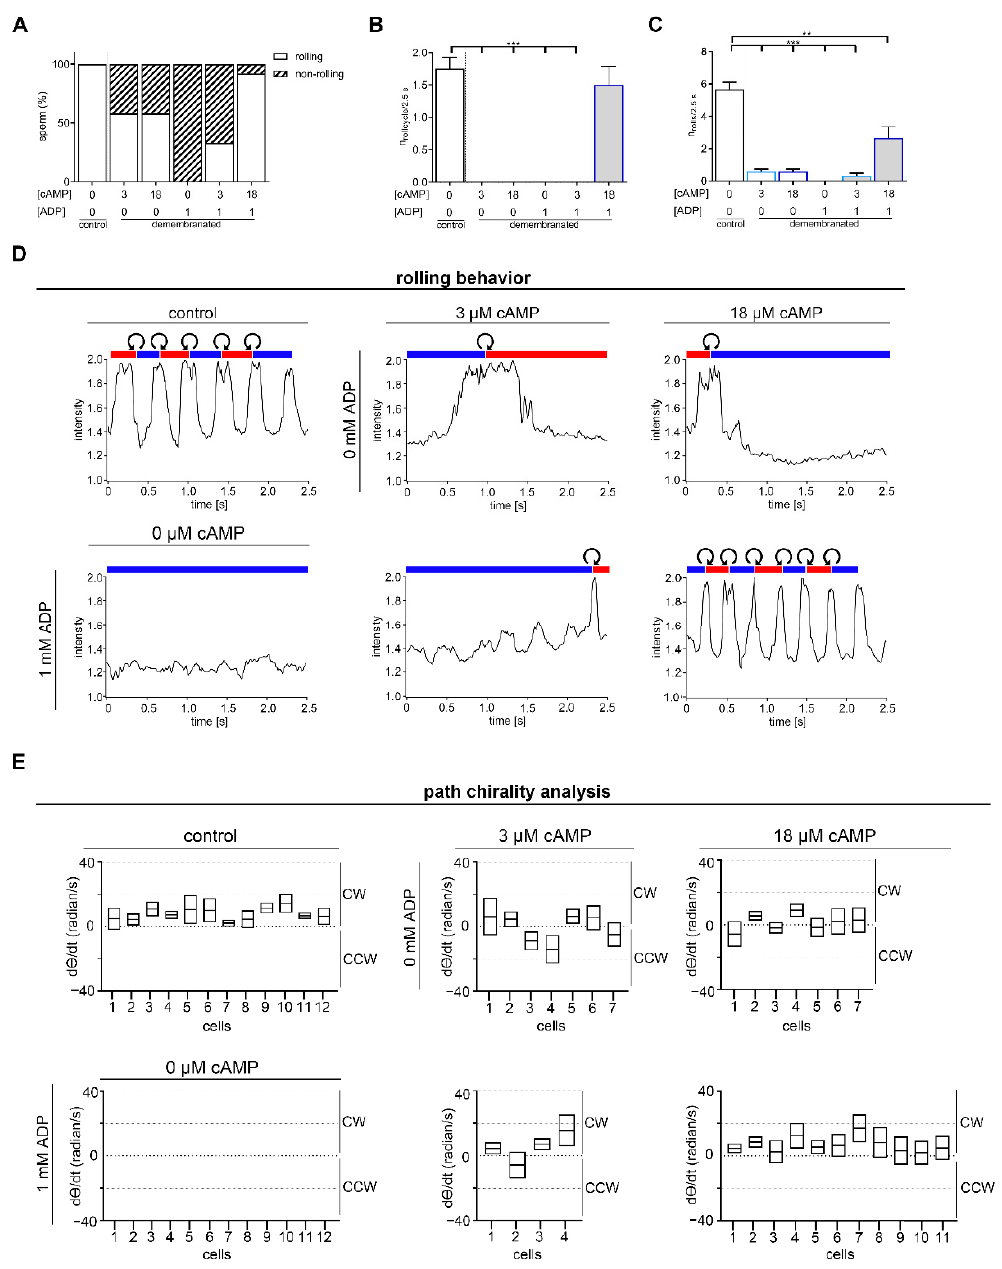
Figure 3. Rolling of sperm requires cAMP and ADP. ( A – C ) Statistical analysis of demembranated murine sperm in the presence of defined cAMP and ADP concentrations (color-coded as in Figure 1) compared to membrane intact sperm. ( A ) Percentage of rolling sperm, ( B ) number of rolling cycles during a 2.5 s recording, where a rolling cycle is defined as RCh-LCh-RCh or vice versa, and ( C ) the number of rolling movements characterized by an increase in intensity of light reflected from the head analyzed. ( D ) Analysis of rolling behavior along the long axis of intact sperm (upper panel, left) and of demembranated sperm under different cAMP and ADP concentrations (upper and lower panels) by measuring the oscillating light intensity which scattered from the sperm head. Red and blue bars indicate periods of “RCh” and “LCh” orientation for the sperm head. The short white areas represent an indeterminate orientation and the curved arrows indicate CW or CCW rolling. ( E ) Path chirality analysis using averaged Procrustes alignments. Positive d θ /dt values indicate a CW and negative values a CCW chirality. Depending on the different rolling behavior of demembranated sperm due to different cAMP and ADP concentration the number of analyzed sperm varied. N = 4, n = 12, mean ± SEM; ** p < 0.01, *** p < 0.001.